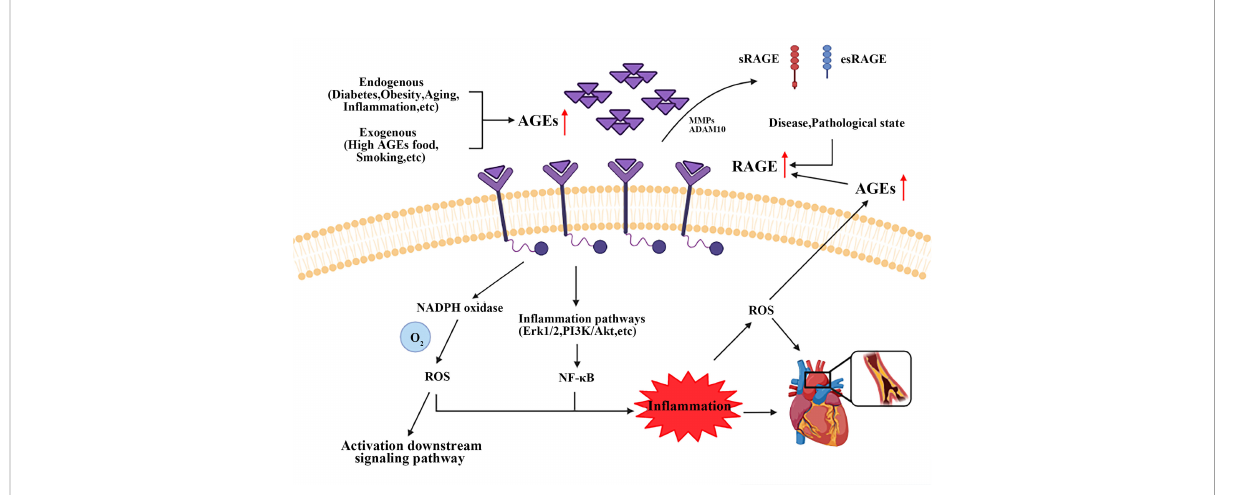
FIGURE 2 Brief mechanism of the interaction between AGEs and RAGE on VSMCs. Endogenous and exogenous pathways increase AGEs content, while disease and pathological states upregulate the expression of RAGE. AGEs-RAGE combination leads to the increase of ROS and activates in fl ammatory signaling pathways, such as Erk1/2, PI3K/Akt and NF- k B. All these events form a positive feedback loop, and ultimately promote AS progress. AGEs, advanced glycation end products; RAGE, receptor for advanced glycation end products. ROS, reactive oxygen